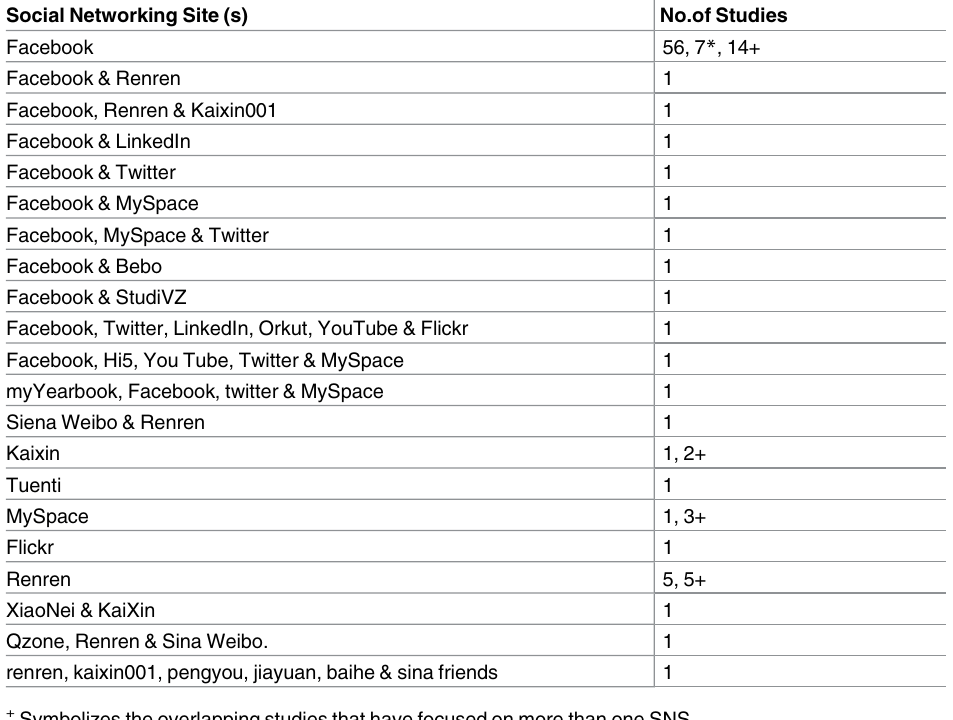
Table 7. Social networking sites discussed in primary